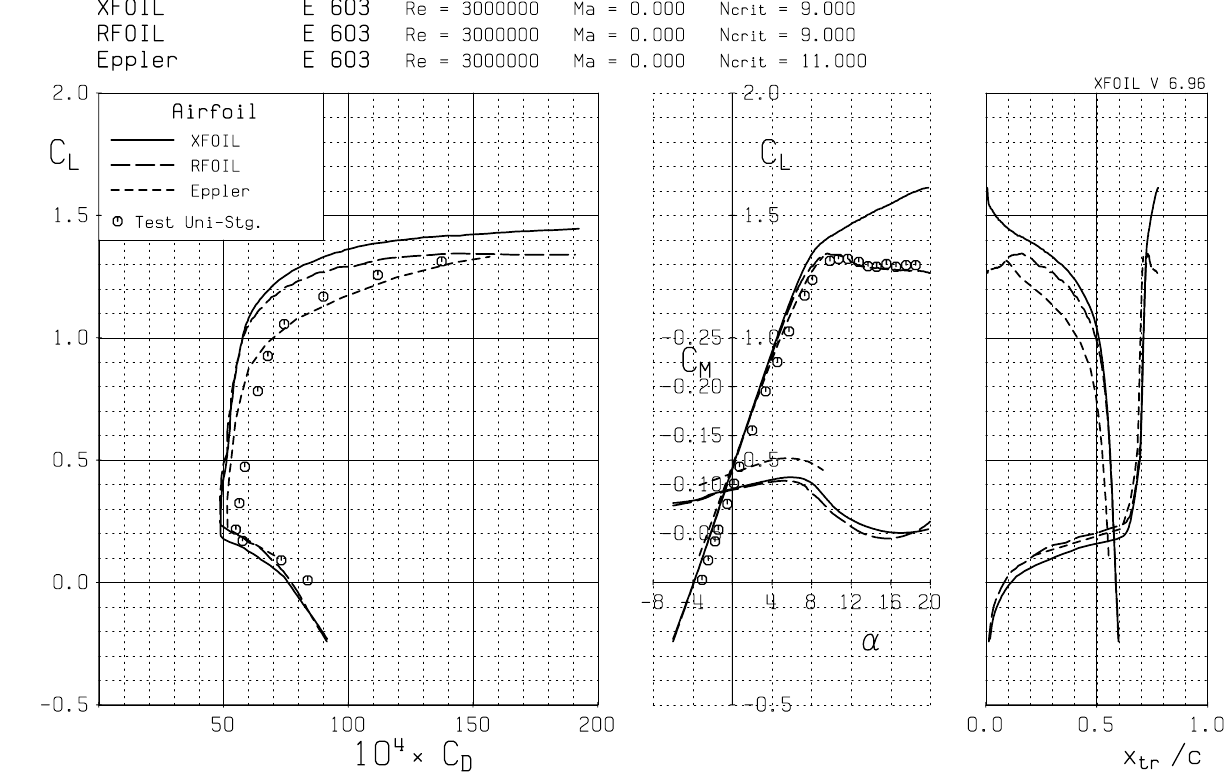
Fig 8. Comparison of calculated and measured data of E603 airfoil at Re = 3·10